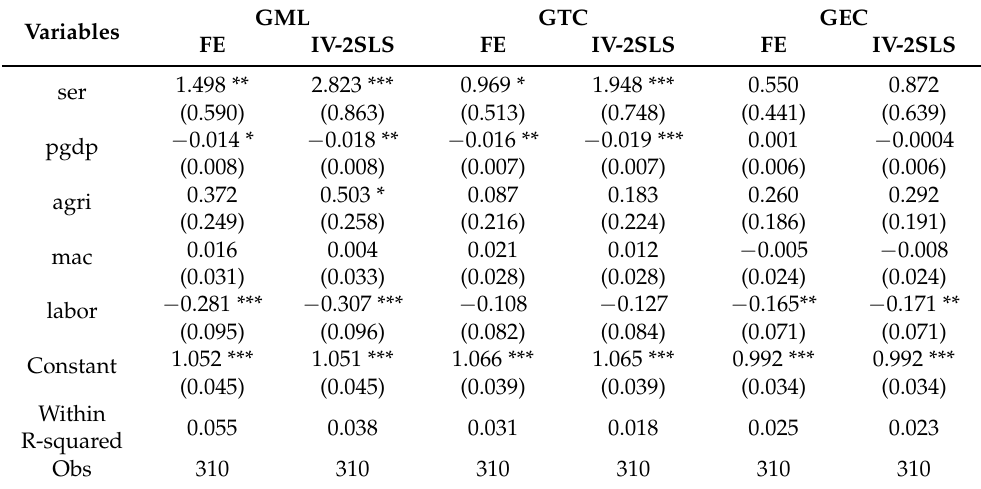
Table 5. Regression results of AGTFP and its